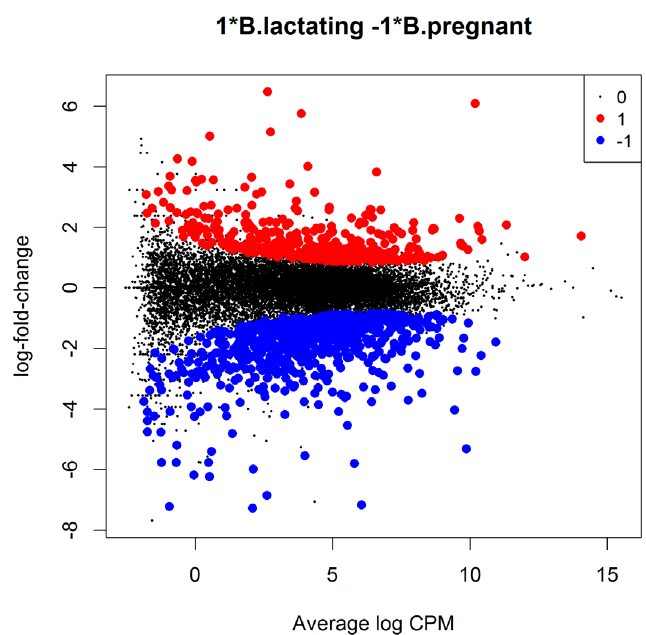
Figure 7. MD plot showing the log-fold change and average abundance of each gene. Genes with fold-changes significantly greater than 1.5 are